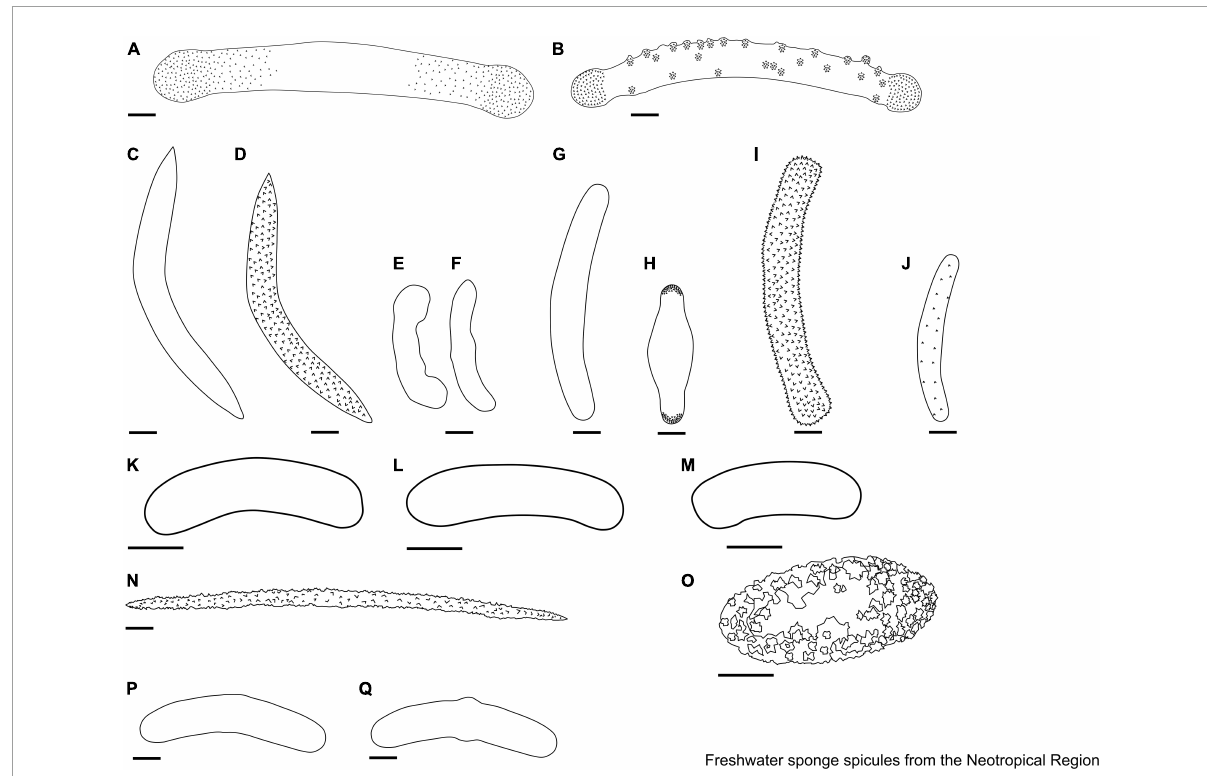
FIGURE13 (A,B) Acanthotylotra Volkmer-Ribeiro, Tavares & Fürstenau-Oliveira, 2009. Megascleres. (A) Strongyles microgranulated with inflated tips; (B) Beta megascleres. (C–J) Oncosclera Volkmer-Ribeiro, 1970. Gemmuloscleres. (C) Smooth oxeas; (D) spined oxeas; (E,F) strongyles irregular; (G) strongyles; (H) strongyles with their median portion inflated, with spines concentrated on the extremities; (I) acanthostrongyles; (J) microspined strongyles. (K–M) Potamophloios Brien, 1970 [1969]. Gemmuloscleres. (K–M) Strongyles. (N,O) Sterrastrolepis Volkmer-Ribeiro & Rosa-Barbosa, 1978. Microscleres. (N) Acanthoxea; gemmuloscleres. (O) Sterrasters. (P,Q) Uruguaya Carter, 1881. Gemmuloscleres. (P,Q) Smooth strongyles can be slightly centrotylotus. Scale: 10 µ m.